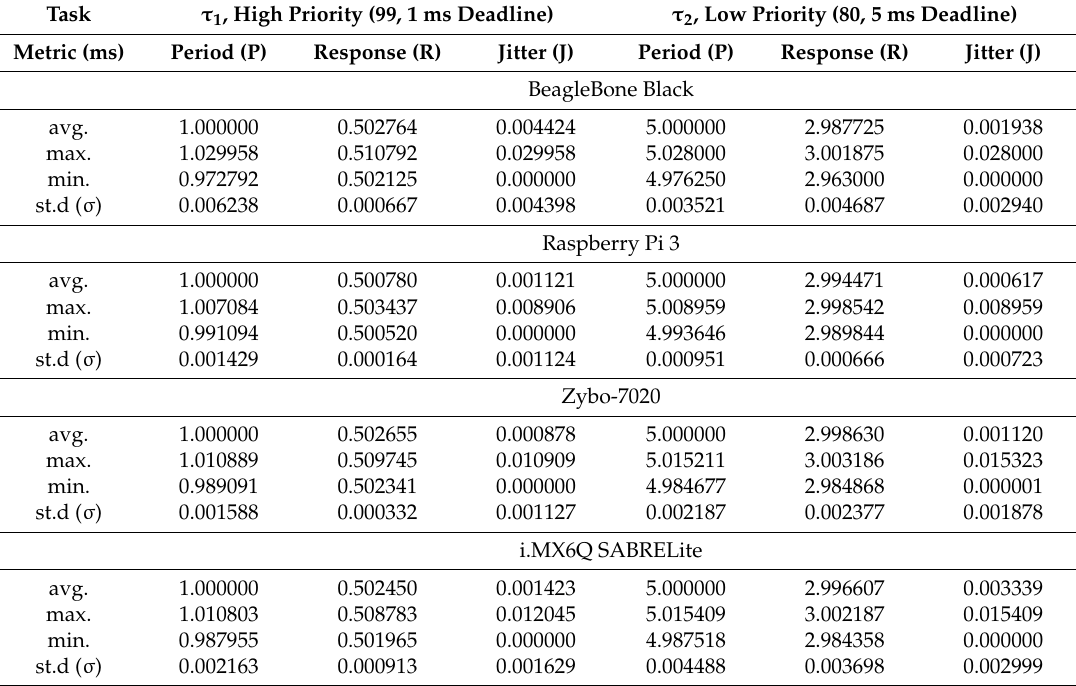
Table 3. Statistical analysis of periodicity and response times of each embedded hardware platform.